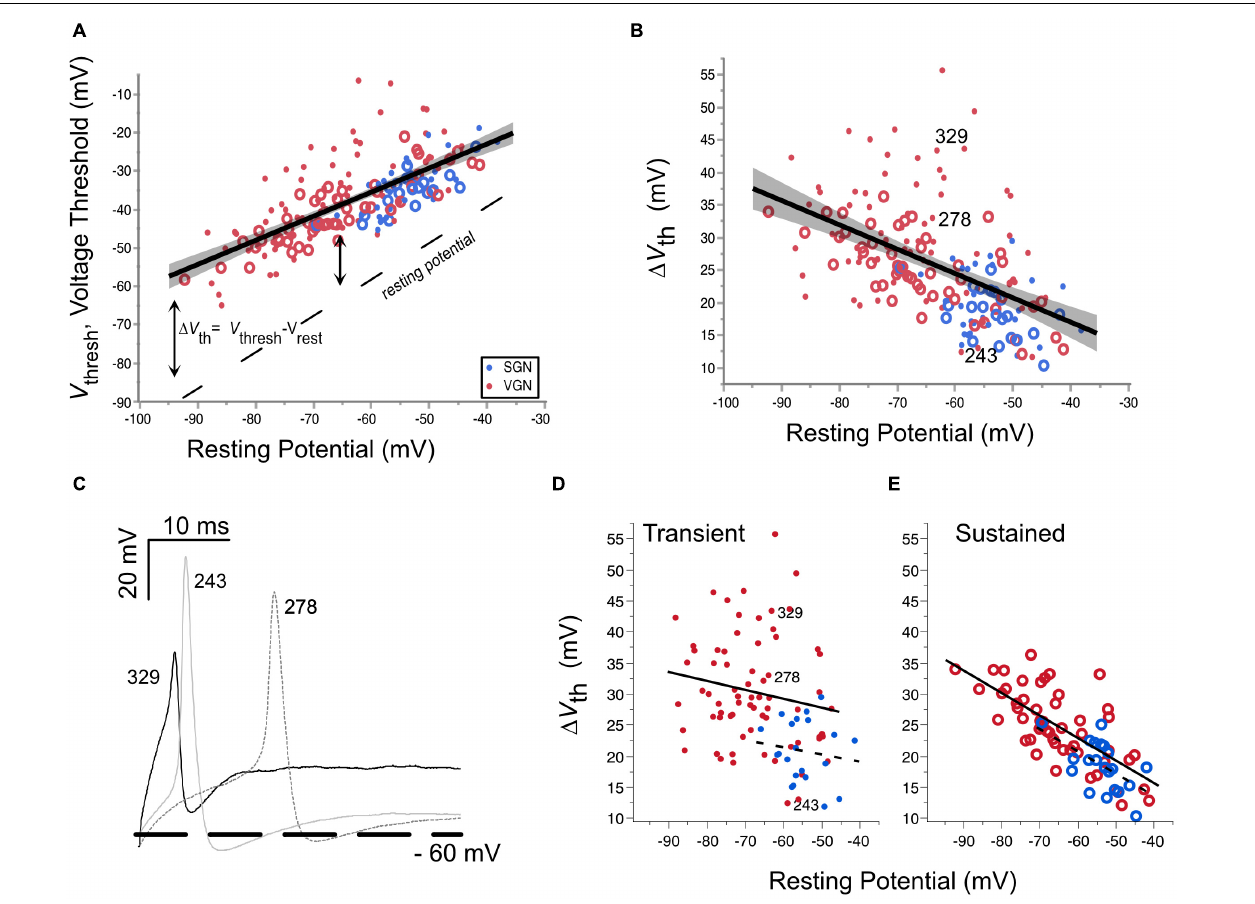
FIGURE 4 | Voltage threshold hyperpolarizes with resting potential in both spiral ganglion and vestibular ganglion. (A) Voltage threshold as a function of resting potential in spiral (blue) and vestibular ganglion neurons (red). Sustained-spiking neurons are drawn with open circles, transient-spiking neurons are drawn with small solid circles. Linear regression through all the SGN and VGN data pooled with 95% confidence intervals drawn as a solid line with gray shading. F (1, 171) = 171.8, p < 0.0001. The dashed line indicates the resting potential. (B) Relative voltage threshold (voltage threshold minus the resting potential) plotted as a function of resting potential. F (1, 171) = 61.6, p < 0.0001. (C) Example spike waveforms illustrating the range of voltage thresholds possible for three transient-spiking neurons from VGN. The cells were chosen to have similar resting potentials near –60 mV. The number next to each trace indicates the cell ID. A thick dashed line is drawn at –60 mV. (D) Voltage thresholds compared between SGN (dashed regression line) and VGN (solid regression line) for cells with transient-firing patterns (dots). (E) Voltage thresholds compared between SGN and VGN for sustained-firing patterns (open circles). Note that sustained- (A,B) firing patterns are pooled together. The cell ID indicates the three cells from (C)